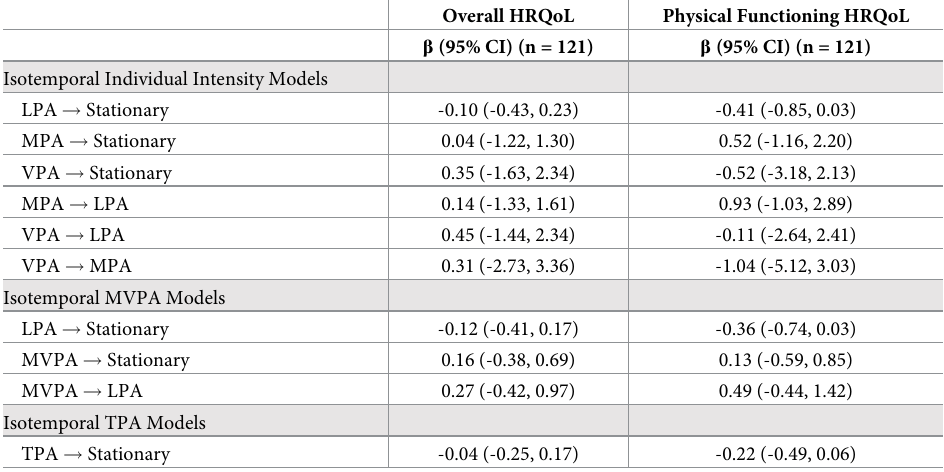
Table 4. Isotemporal substitution of movement behaviors with health-related quality of life in preschool children with overweight and obesity participating in the baseline assessment of the TX CORD secondary prevention study (N =